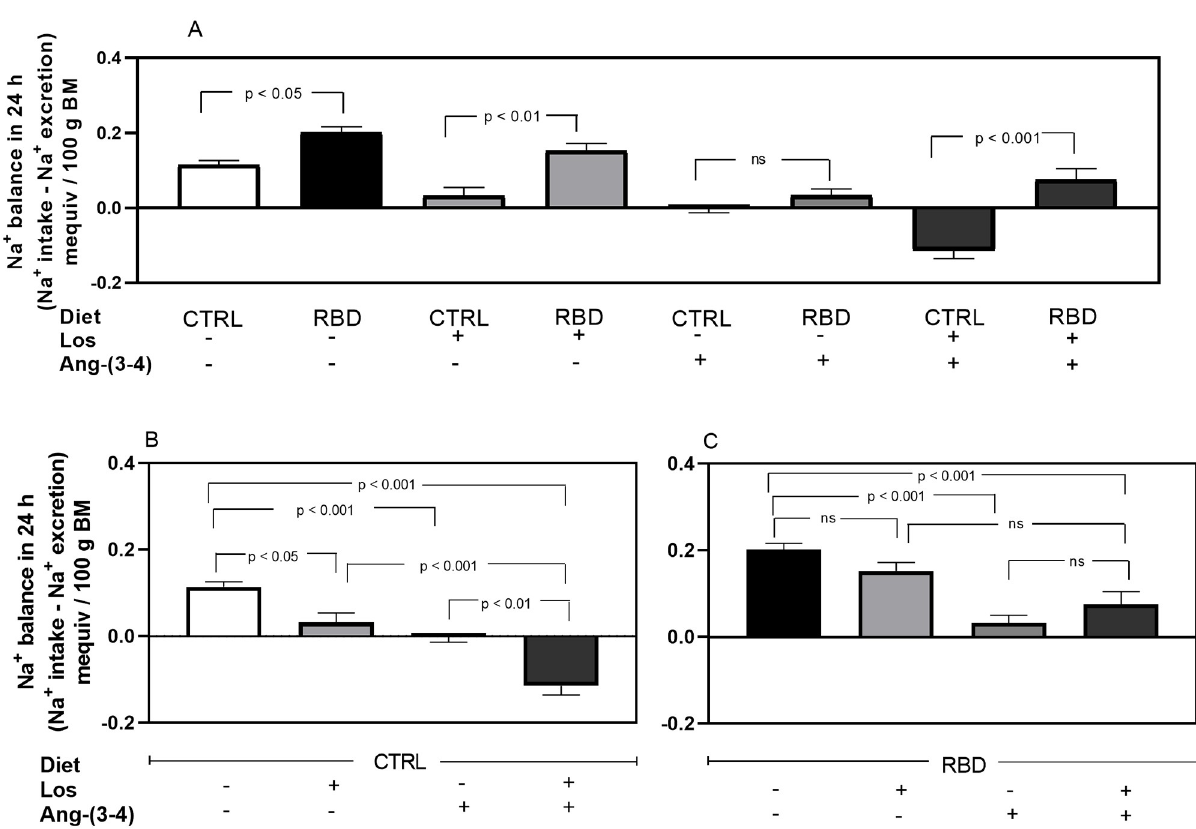
Fig 11. Na + balance. Na + balance (mequiv in 24 h/100 g BM) was calculated as the difference between Na + intake and urinary Na + excretion (Figs 5 and 10, respectively). The combinations of diets and treatments are indicated on the abscissae . (A) Effects of RBD administration without treatments or after treatment with Losartan, Ang-(3–4) or Losartan plus Ang-(3–4). (B) Effects of treatments in CTRL rats. (C) Effects of treatments in RBD rats. Bars are mean ± SEM; n = 5 (CTRL), n = 8 (RBD), n = 5 (CTRL+Los), n = 6 (RBD+Los), n = 5 (CTRL+Ang-(3–4)), n = 7 (RBD+Ang-(3–4)), n = 5 (CTRL +Los+Ang-(3–4)), n = 6 (RBD+Los+Ang-(3–4)). Differences between means were analyzed using one-way ANOVA followed by Bonferroni’s test for selected pairs. P values are given within the panels.